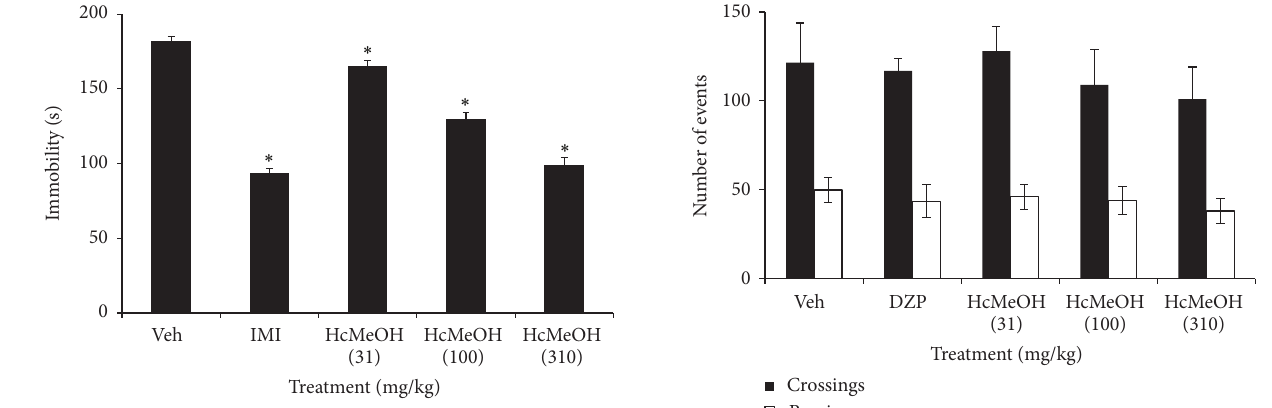
Figure 1: Effect of oral administration of Heteropterys cotinifolia methanolic extract on immobility time of ICR mice exposed to FST. ∗ 𝑃 < 0.05 with ANOVA followed by a post hoc Dunnett test (mean ± S.D.). Veh, vehicle; IMI, imipramine hydrochloride; HcMeOH, methanolic extract of Heteropterys cotinifolia.